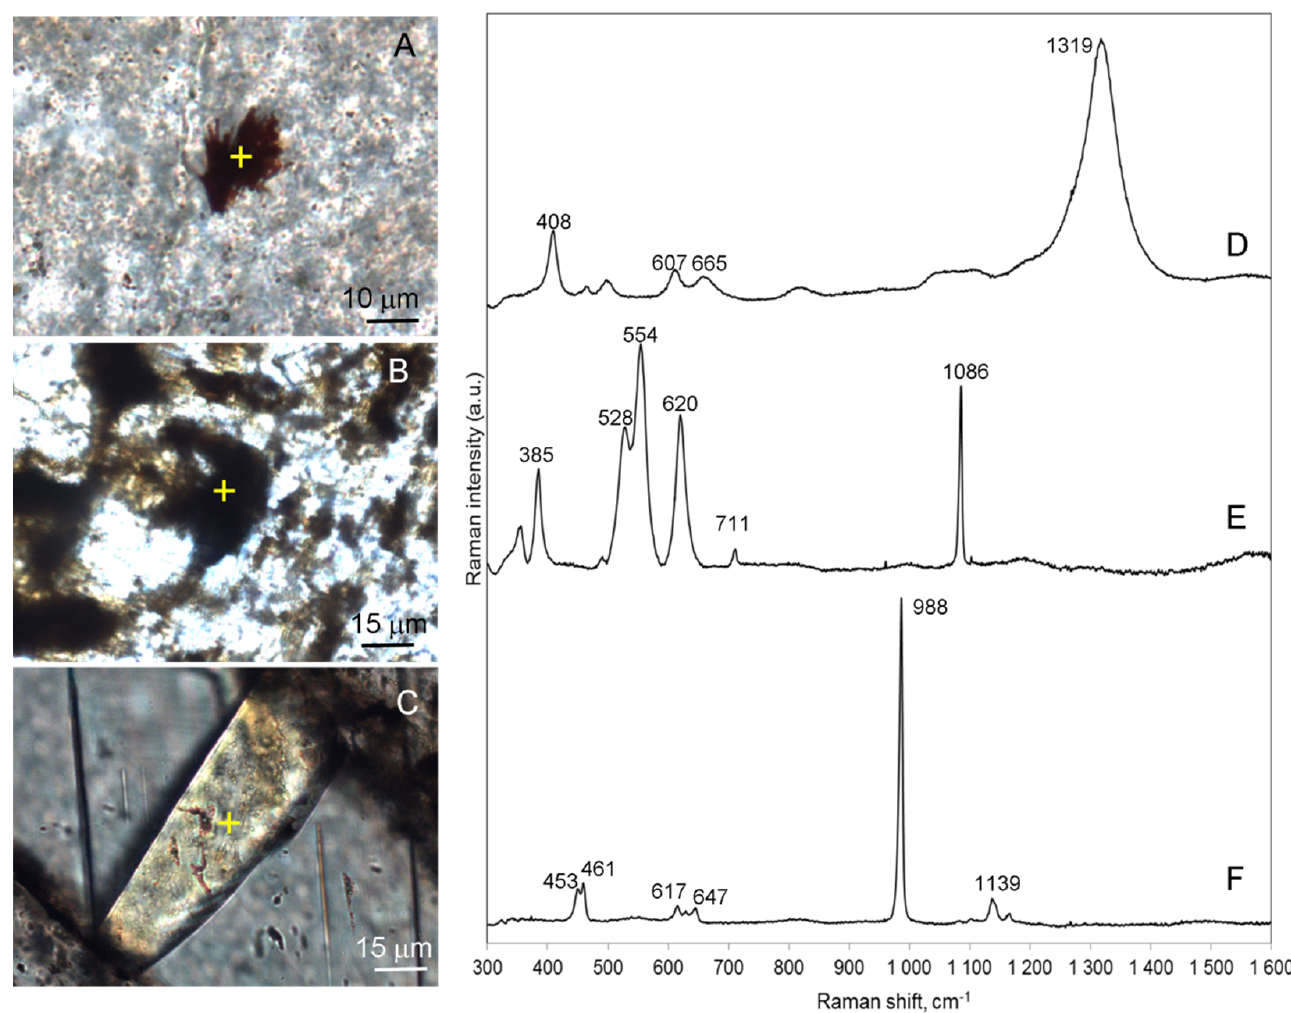
Figure 8. Micrographs (transmitted light mode) and Raman spectra of hematite ( A , D ), manganite ( B , E ), and barite ( C , F ) inclusions in the agates in the spectral range of 300 − 1600 cm − 1 . The analytical spots are marked by yellow crosses. Bands at 711, 1086 cm − 1 on Figure ( E ) corresponds to calcite. According to the local Raman study of mineralized gas vesicles in mandelstones, they are filled with alpha-quartz, calcite, and chlorite. The plate-like chlorite crystals predomi- nantly fill the central parts of greenish zoned amygdales from either mandelstone types are characterized by similar Raman bands at 355 − 367 cm − 1 , 541 − 548 cm − 1 , 673 − 677 cm − 1 , and diffused bands at 3600 − 3657 cm − 1 (Figure 9). The apparent downshift in the Si-O-Si related Raman band to 673 − 677 cm − 1 (from the 681 − 683 cm − 1 of Mg-rich chlorite) [31], together with the high intensity of the band at 355 − 367 cm − 1 suggest an intermediate Mg-Fe composition of examined chlorites. In the spectral range of H 2 O/OH vibrations (3400–3700 cm − 1 ), the Raman spectral patterns from studied chlorite samples show in- significant variations, which are most probably related to different proportions of Mg and Fe in the structure of chlorite